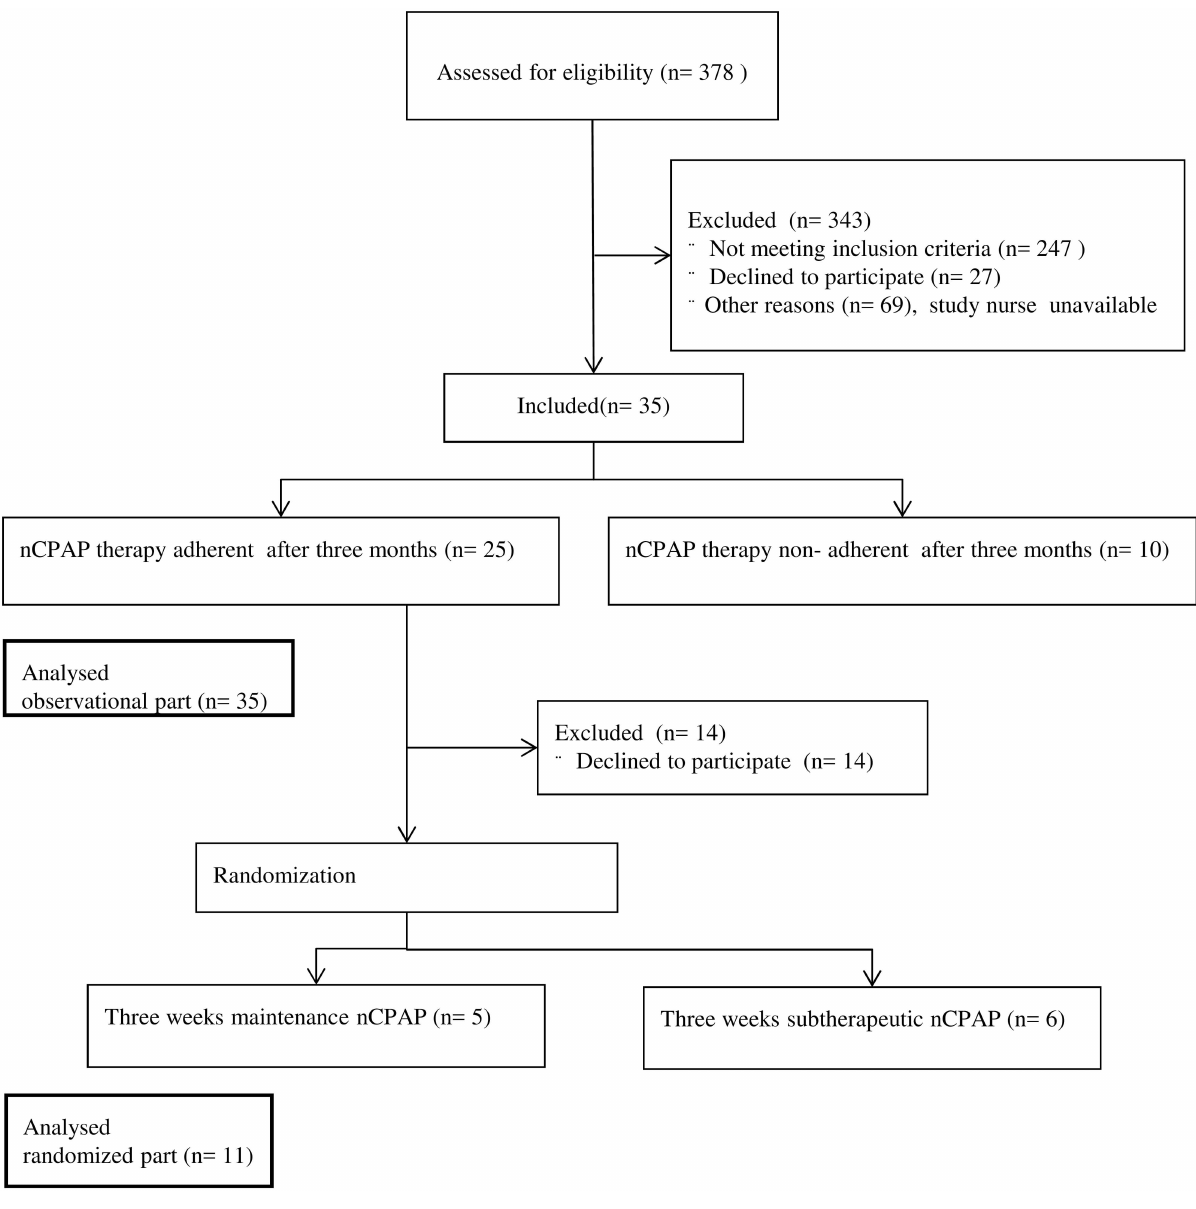
Fig 1. Flowchart of the